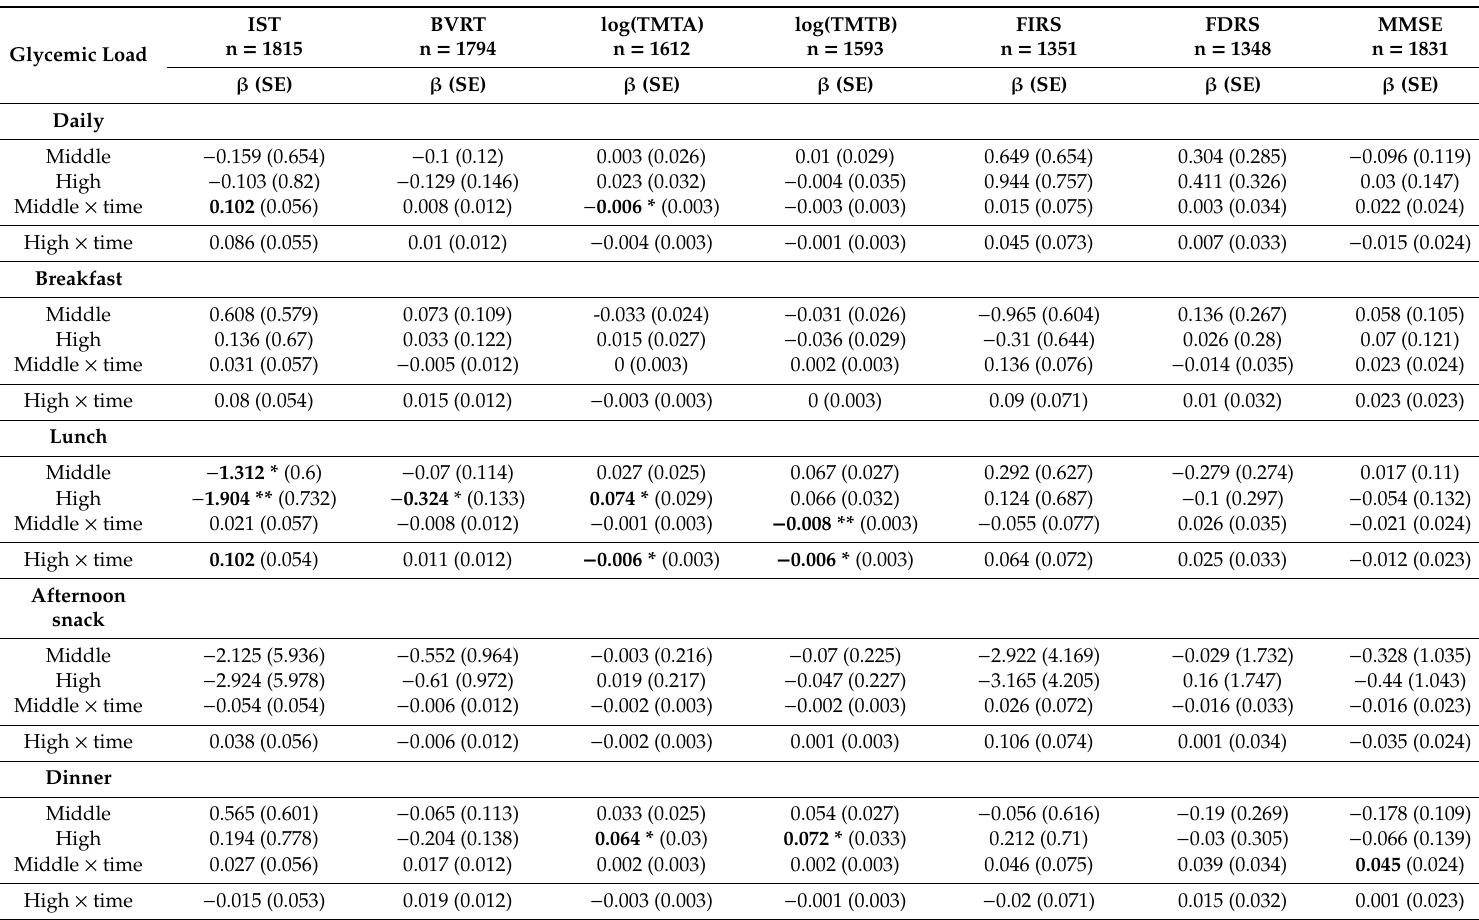
Table 2. Associations of glycemic load with cognitive changes in APOE4 non-carriers (12-year